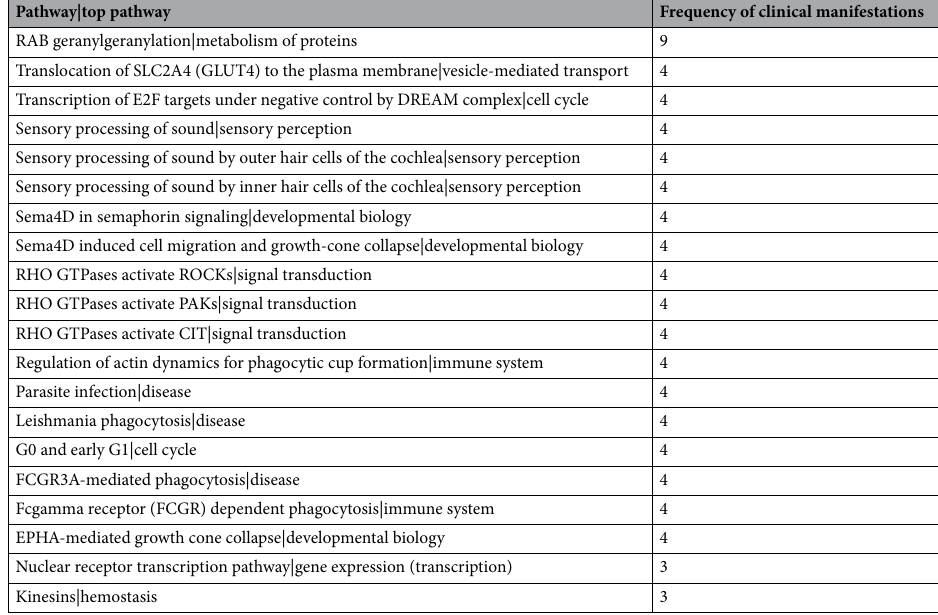
Table 3. Top 20 most frequent pathways across the interactome clinical manifestations.